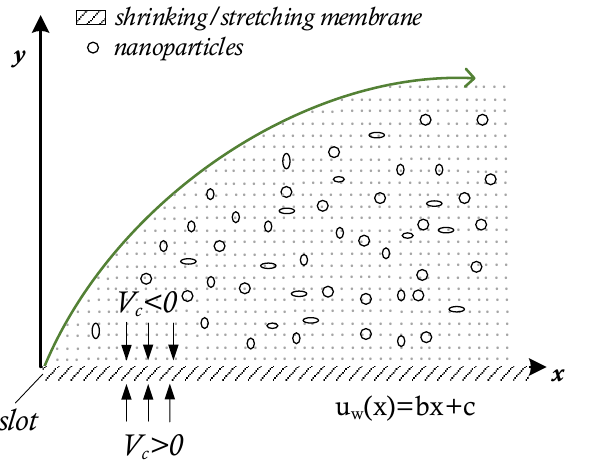
Figure 1. Schematic representation of the implied